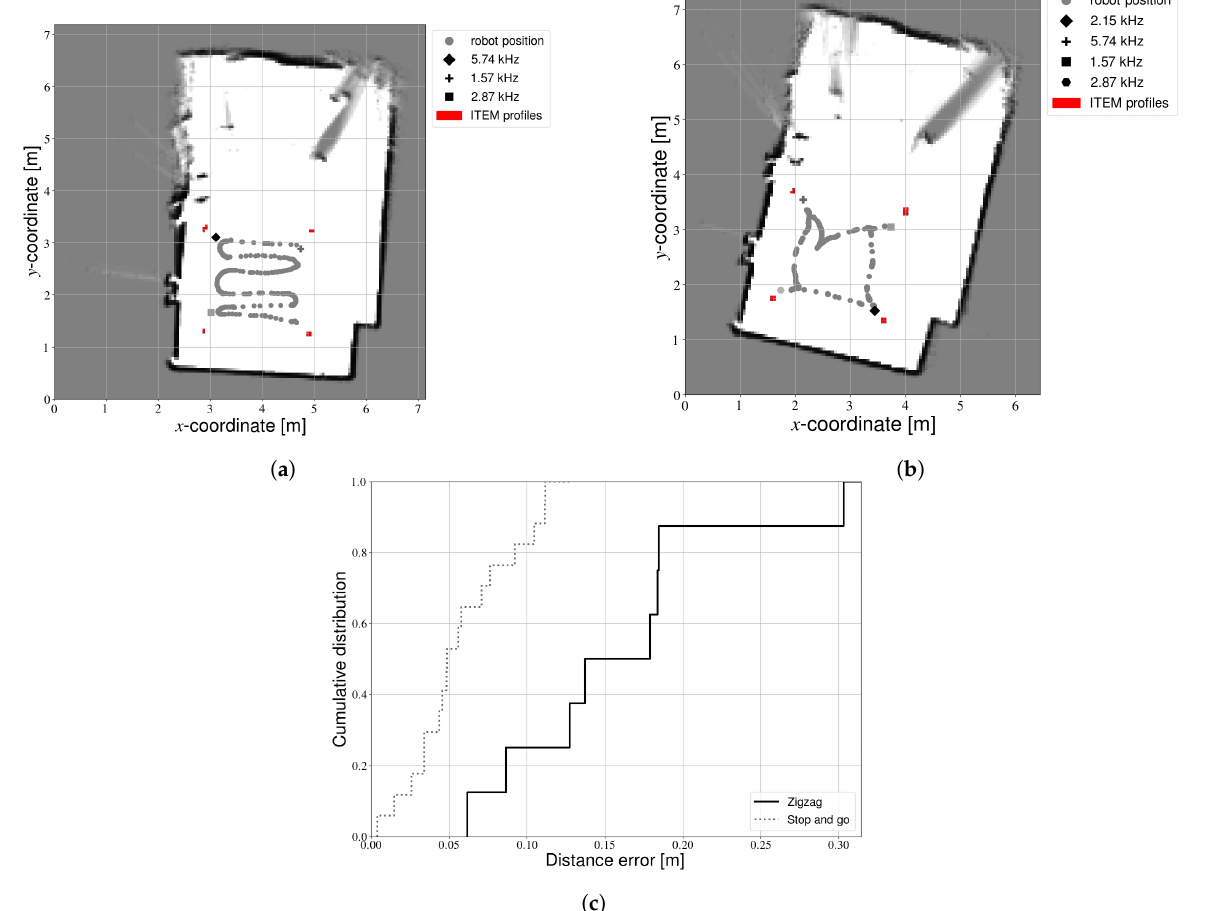
Figure 8. Calibration experiments with different trajectories. ( a ) Zigzag trajectory. ( b ) Stop and go trajectory. ( c ) Cumulative error